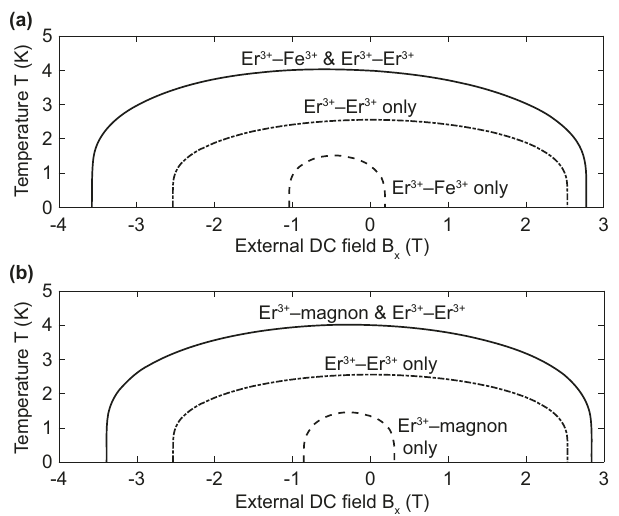
Fig. 5 Phase boundaries of the low-temperature phase transition (LTPT) in ErFeO 3 . Boundaries calculated using the ( a ) mean- fi eld method and ( b ) semiclassical method with the extended Dicke Hamiltonian. An external direct current (DC) magnetic fi eld is applied along the a axis. The solid curves are the phase boundaries determined using the full Hamiltonian, and those in Figs. 5a and 2a are equivalent. The dashed-dotted curves are the phase boundaries in the absence of Er 3 þ – magnon coupling (Er 3 þ – Fe 3 þ exchange interactions). The dashed curves are those obtained in the absence of Er 3 þ – Er 3 þ exchange interactions, i.e., the LTPT can be caused solely by the Er 3 þ – magnon coupling and thus can be interpreted as a magnonic superradiant phase transition